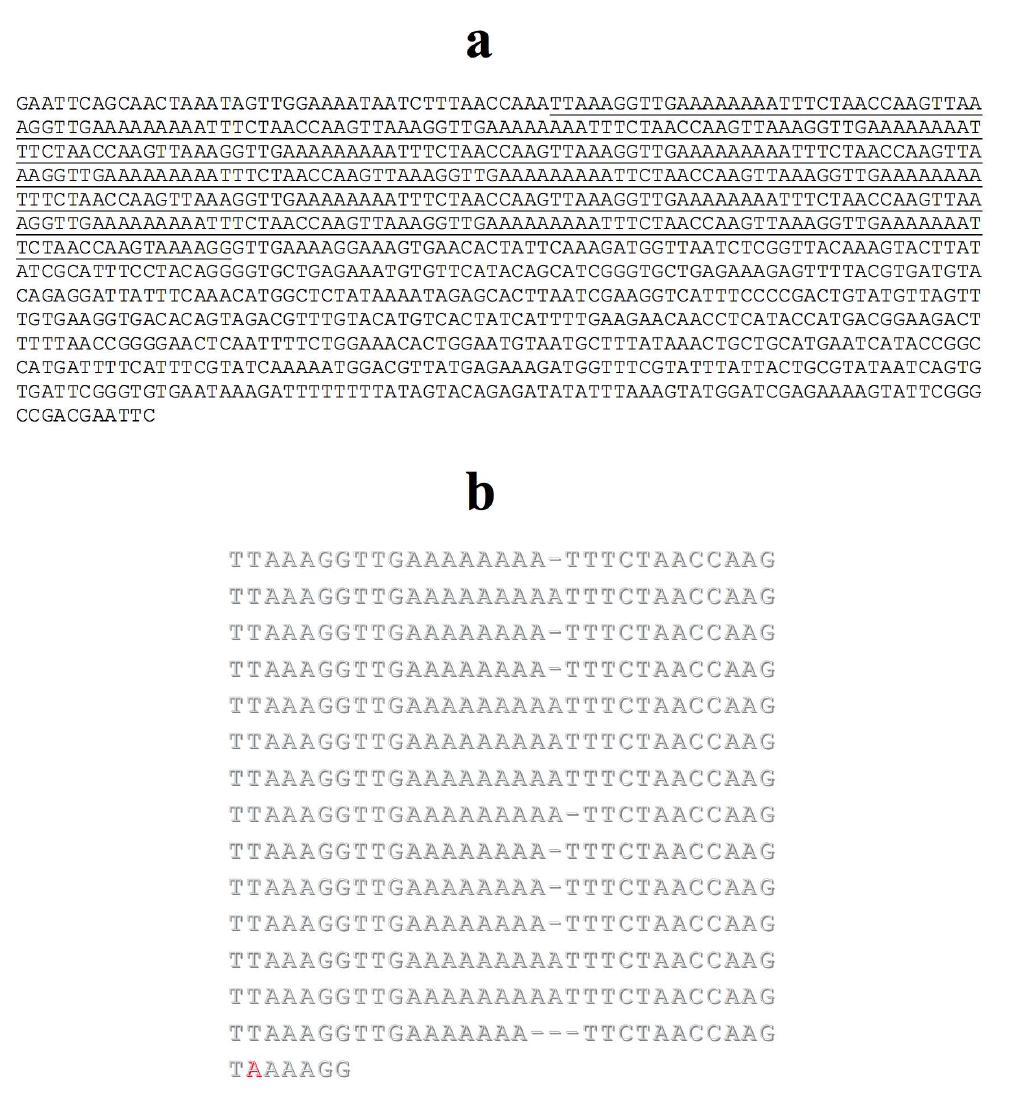
Figure 9. p Tp 2.4 insert sequence ( a ); stretches comprising tandem repeats are underlined. ( b ) The manual alignment was done with repeats taken individually; a single divergence in relation to the most frequent base within a column was identified in red. Gaps (-) were introduced to optimize the alignment. The p Tp -2.4 plasmid was labelled and then used for in situ hybridization in polytene chromosomes of T. pubescens . The most intense hybridization signals were detected in several interstitial chromosome regions namely, no apparent preference for chromosome ends was observed (Figure